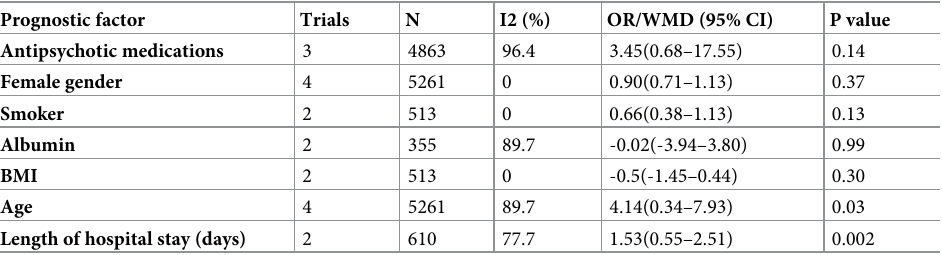
Table 4. Potential risk factors for delirium in hospitalized